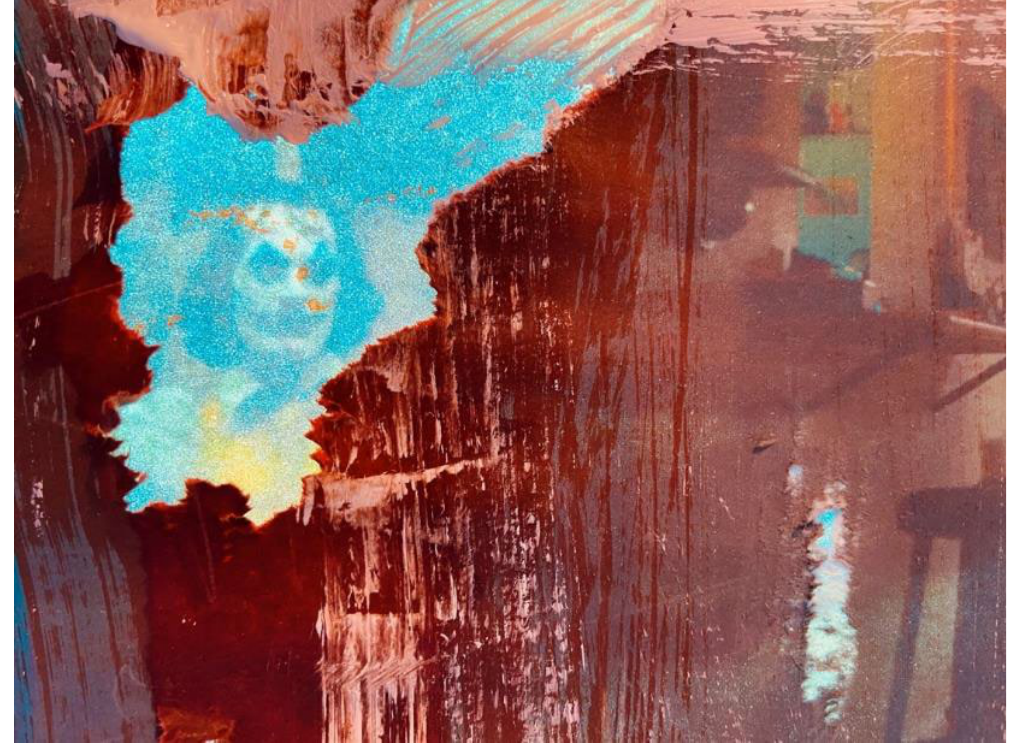
Figure 53 Journal Collage 3 (detail) Illuminated layers are revealed